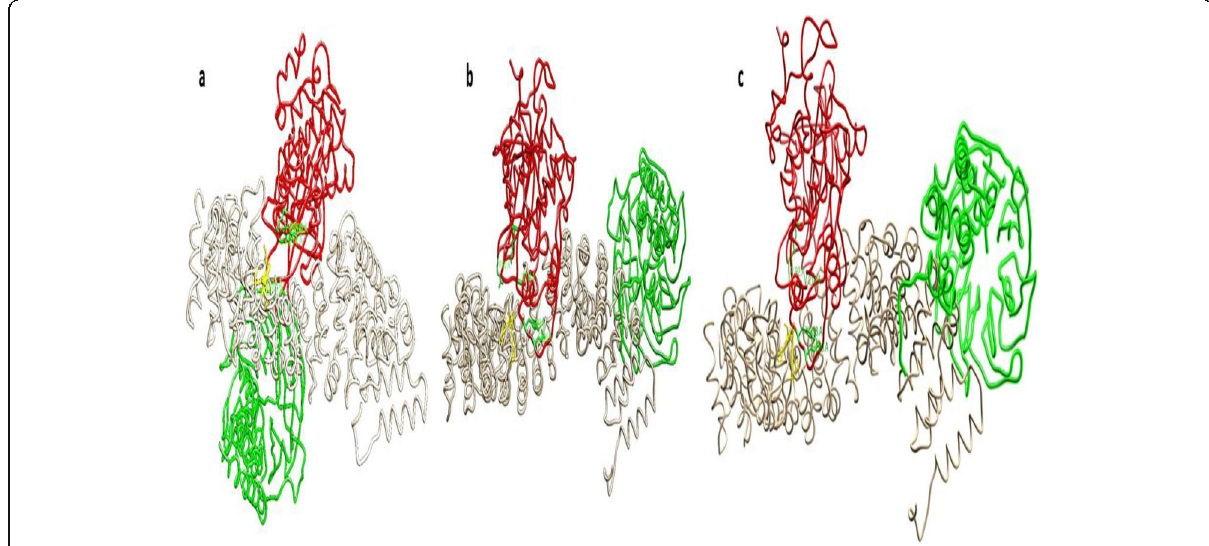
Fig. 5 Molecular docking analysis of CTNNB1 WT and CTNNB1 MT (S33F and T41A) with GSK3 and TrCP1. a Wild type ( b ) CTNNB1 S33F and ( c ) CTNNB1 T41A Tan color ribbon represents CTNNB1 along with destruction motif shown in yellow. GSK3 is shown in red ribbon with interacting residues shown in green sticks. TrCP1 is represented in green